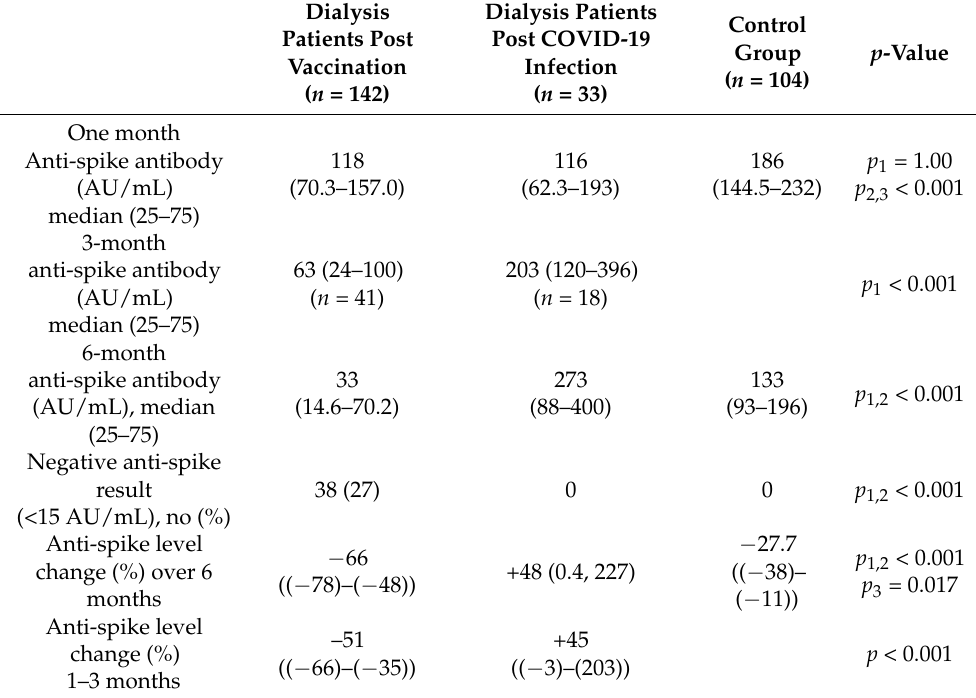
Table 2. Anti-spike antibody levels.